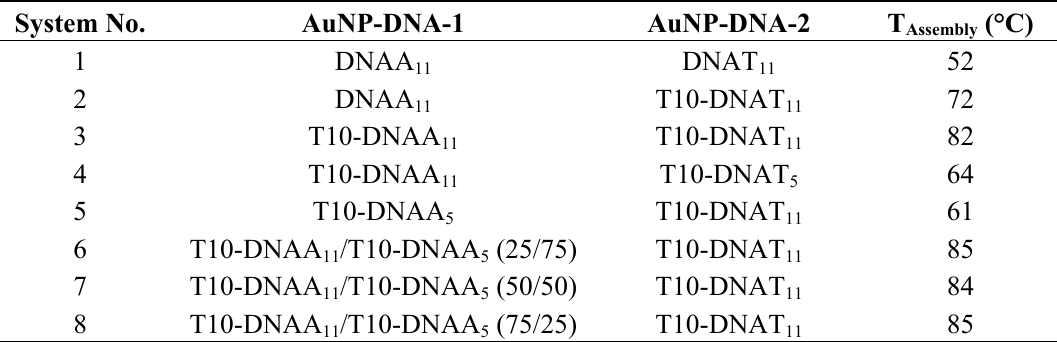
Table 2. Characteristic assembly temperature (±1 °C) of the different systems obtained by mixing AuNP with complementary oligonucleotide strands. System